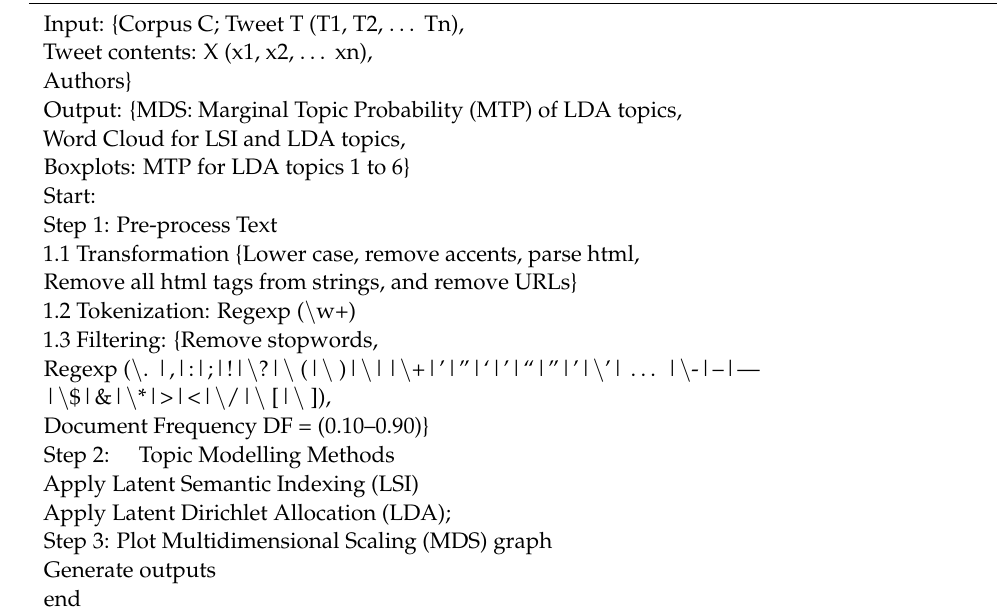
Algorithm 2: Workflow for the Topic Modelling.